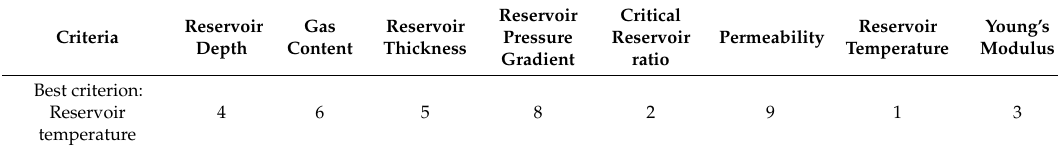
Table 3. Comparison vector for the worst